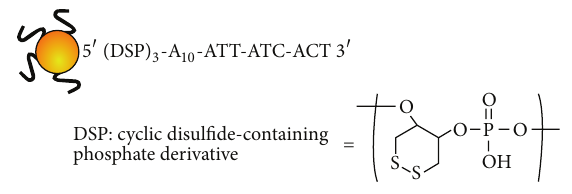
Figure 11: Conjugation of AgNPs with oligonucleotides by using DSP as a linker molecule (adapted from